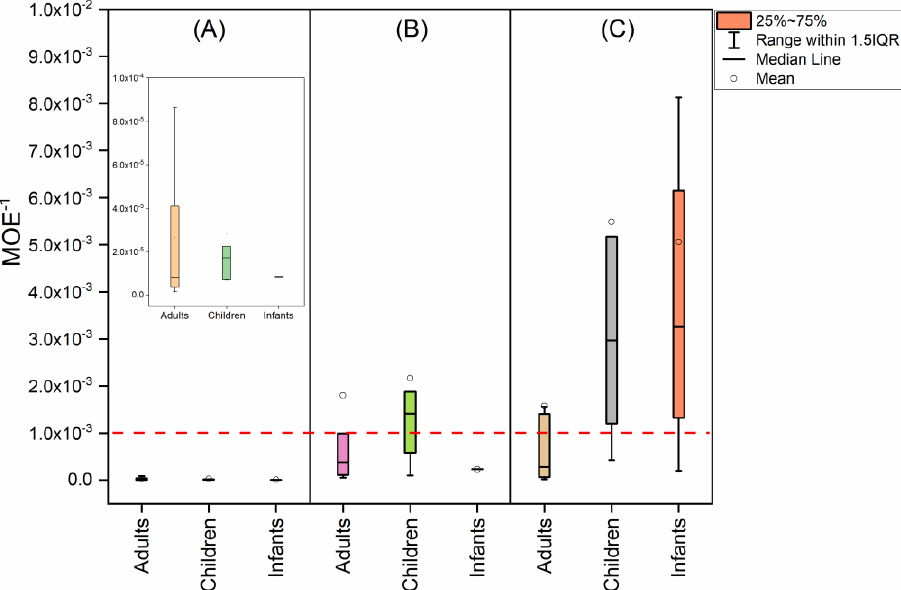
Figure 7. Risk of SCCPs for adults, children and infants via three main exposure routes. An MOE − 1 greater than 0.001 (red dashed line) is considered to pose health risk potential. ( A ) Potential risk of SCCPs through inhalation exposure. ( B ) Potential risk of SCCPs through ingestion and dermal exposure. ( C ) Potential risk of SCCPs through dietary exposure. (inset) Potential risk of SCCPs for adults, children and infants via inhalation exposure. Data on inhalation exposure and ingestion and dermal exposure in infants were limited.